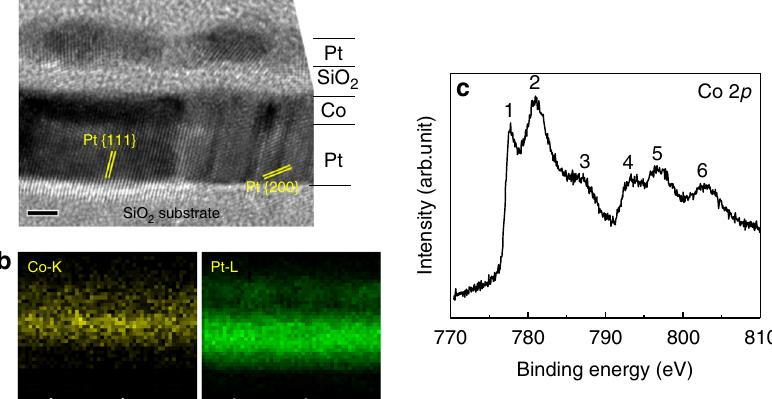
Fig. 1 Crystal and interface-electronic structures. a Cross-sectional high-resolution transmission electron microscopy image of a Pt (5)/Co (1)/SiO 2 (1)/Pt (1) (nm) fi lm (scale bar 2 nm). b Co and Pt elemental mapping obtained by energy-disperse X-ray spectroscopy (scale bar 10 nm). c X-ray photoelectron spectroscopy spectrum of Co 2 p level near the Co/SiO 2